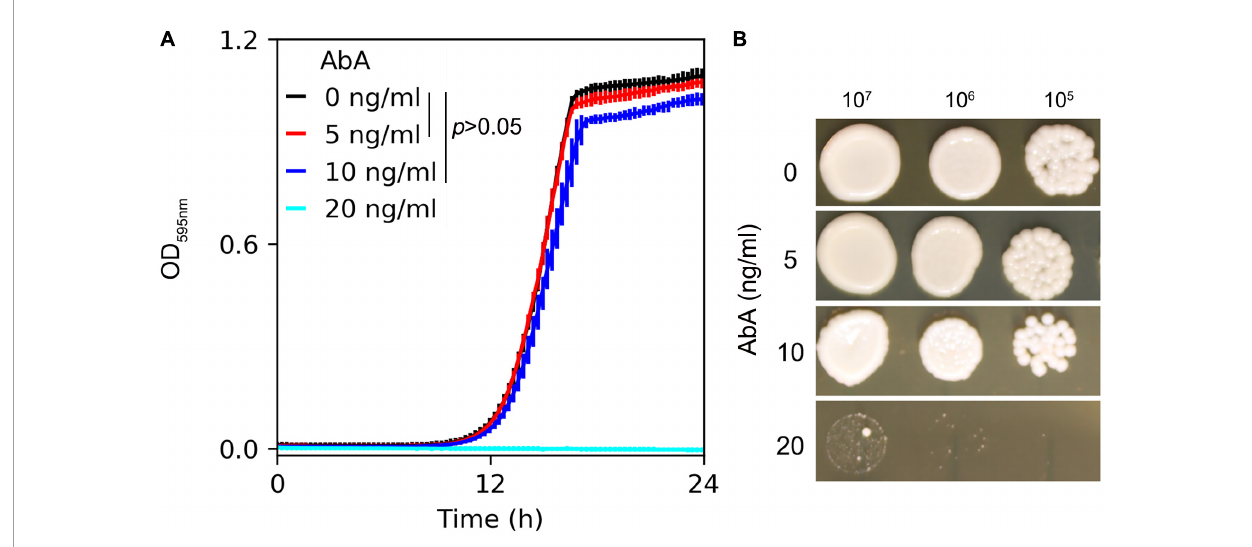
FIGURE1 Susceptibility of C. albicans to aureobasidin A. C. albicans lab strain SC5314 was grown in YPD broth (A) or on YPD plates (B) supplemented with aureobasidin A. In panel (A) optical density at 595 nm (OD 595 ) was measured every 15 min for 24 h at 37 ◦ C using a Tecan plate reader (Infinite F200 PRO, Tecan, Switzerland). Data are represented as the mean ± SD of three biological repeats. In panel (B) , 3 µ l of 10-fold serial dilutions were spotted on YPD plates. Drug concentrations are shown in the figure. The plates were incubated at 37 ◦ C for 48 h then